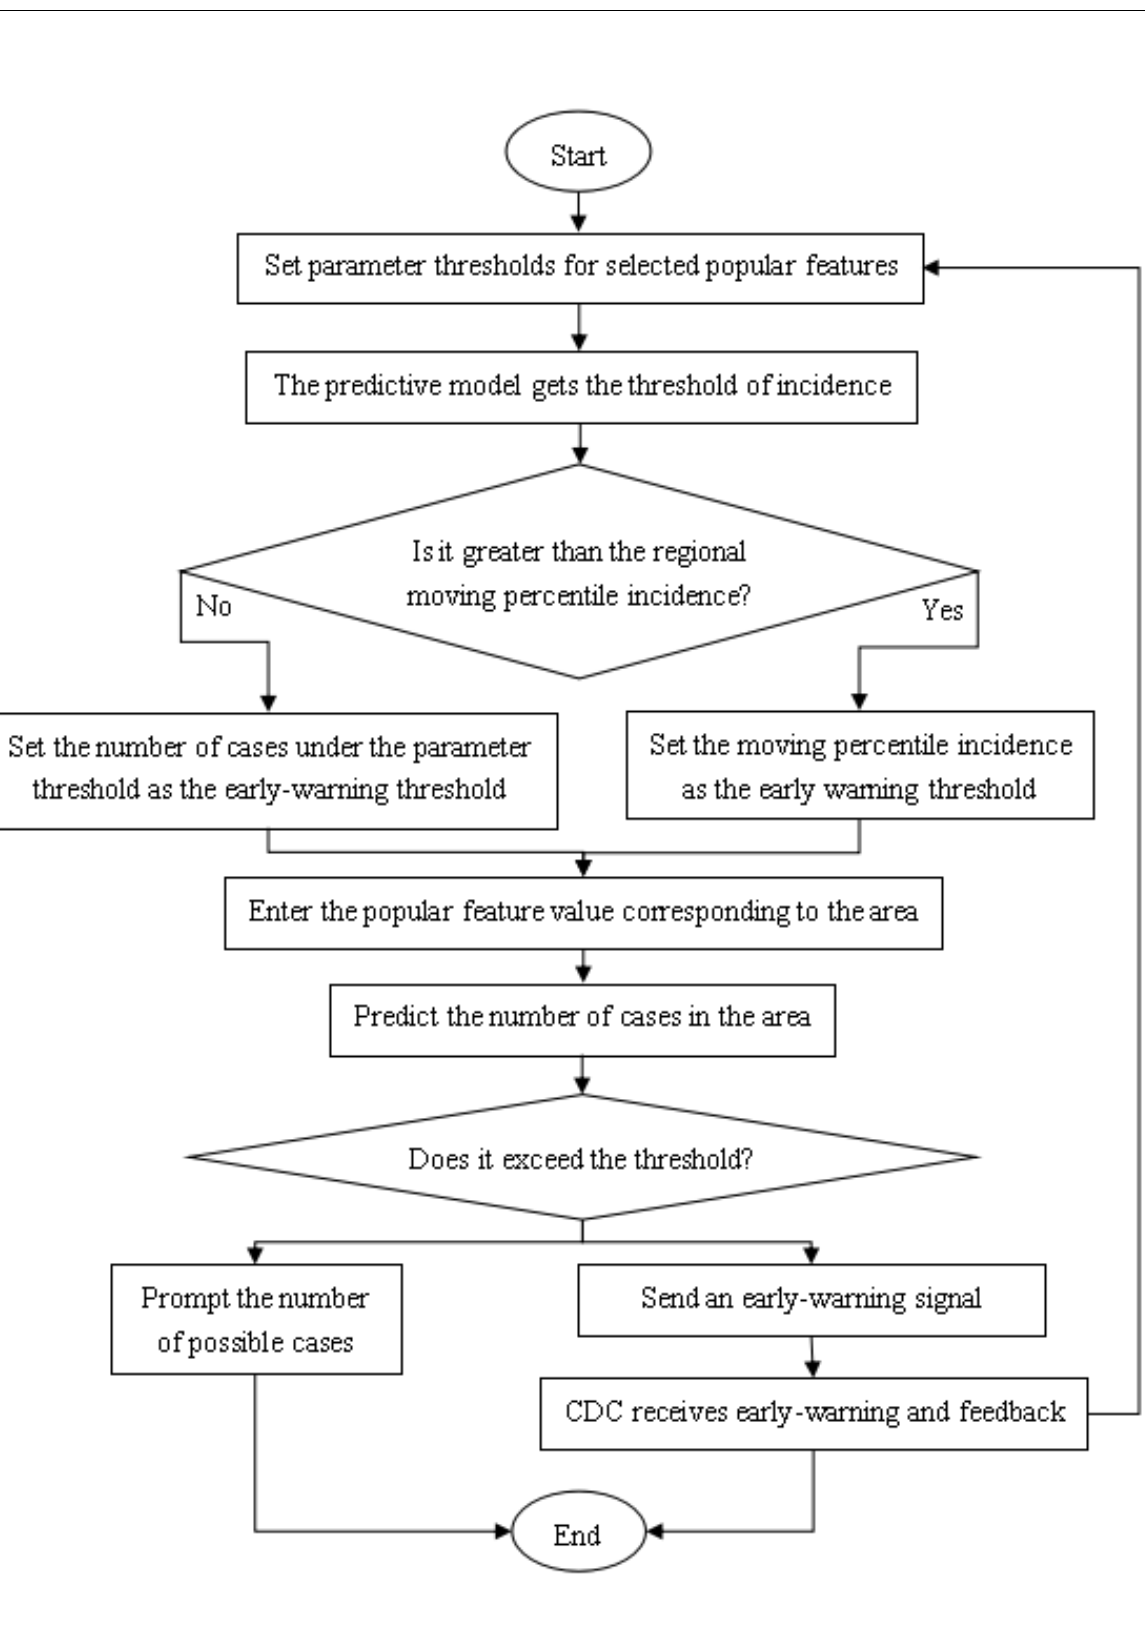
Figure 10. Flow chart of HFMD epidemic warning model based on threshold